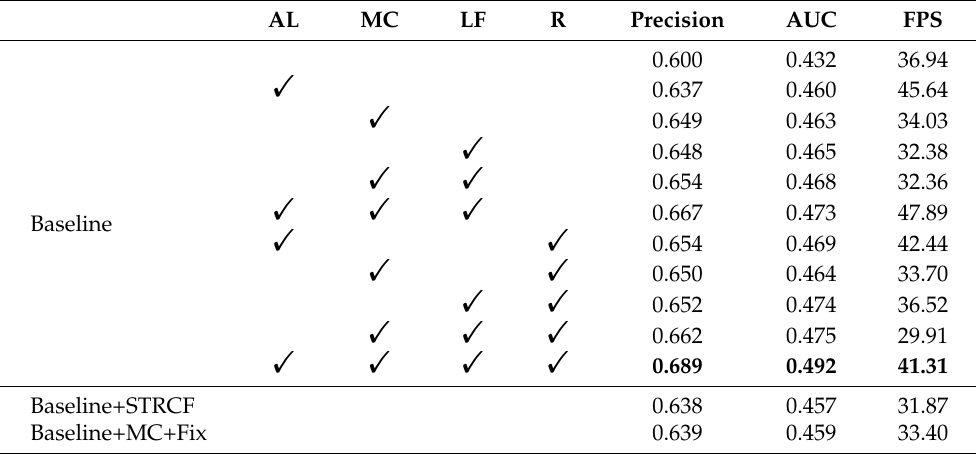
Table 2. Ablation analysis. R represents the response map regularization term. AUC represents the success rate (top 1 in bold.